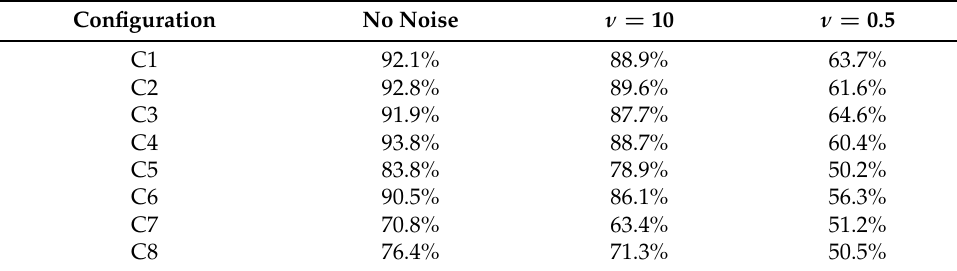
Table 7. Accuracy of the Vgg on each dataset configuration corrupted by various levels of multiplica- tive noise.